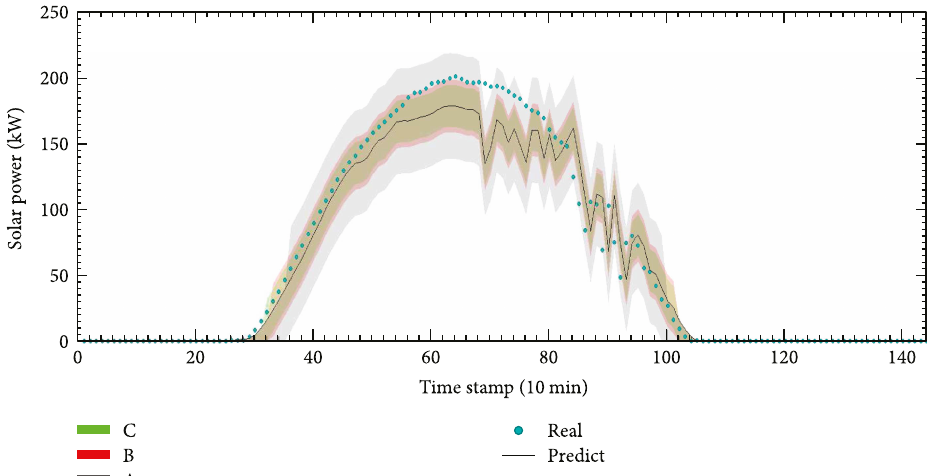
Figure 8: Fuzzy interval prediction for one day ahead (case 2) solar power with coverage grades.